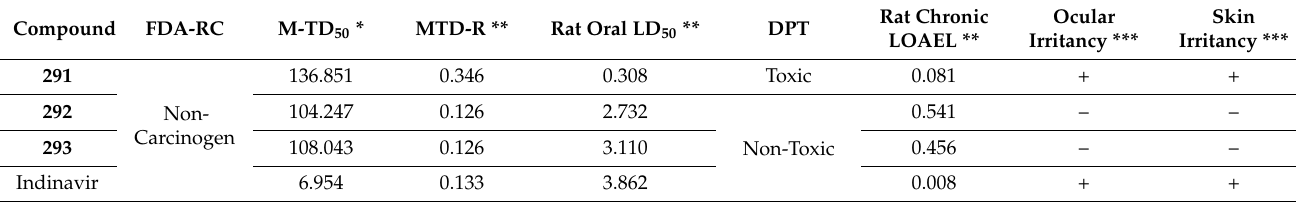
Table 4. Toxicity properties of metabolites 291 , 292 , and 293